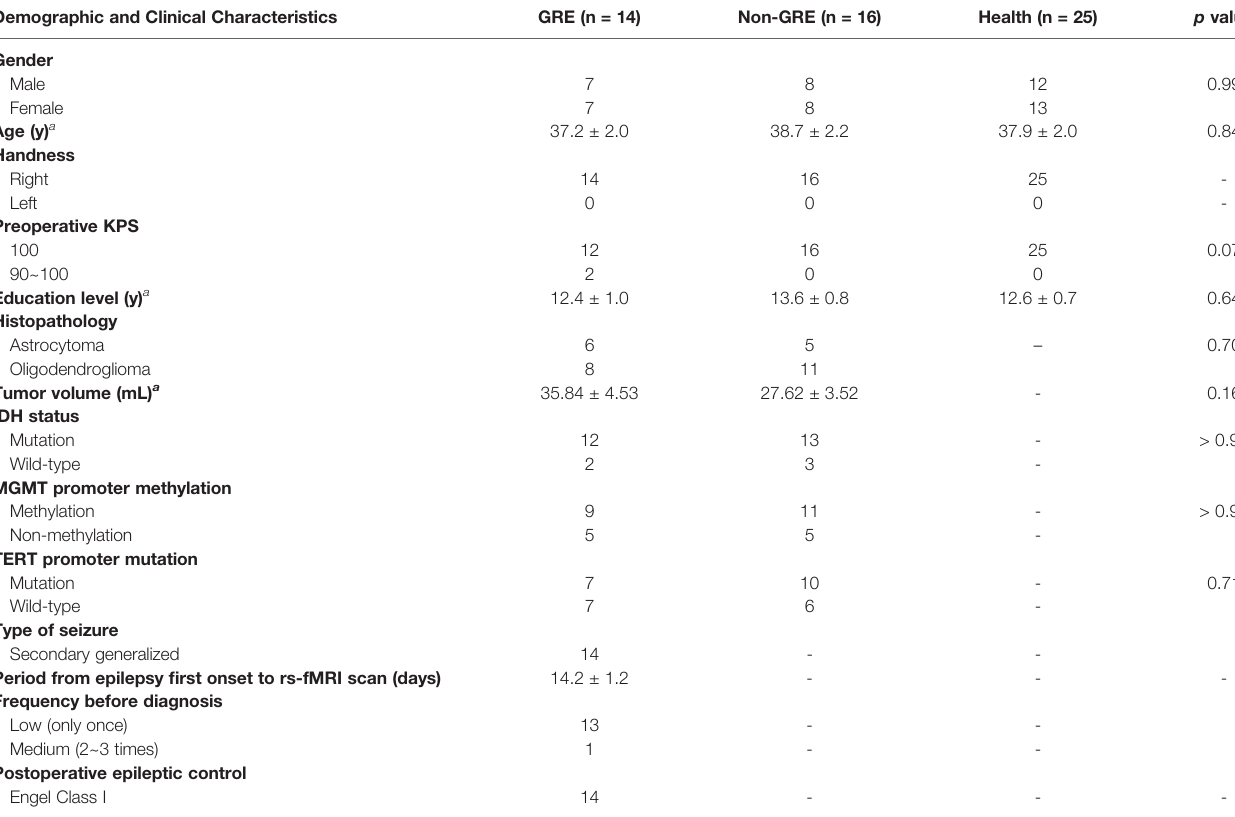
TABLE 2 | Demographic and clinical characteristics of patient with right prefrontal gliomas. Demographic and Clinical